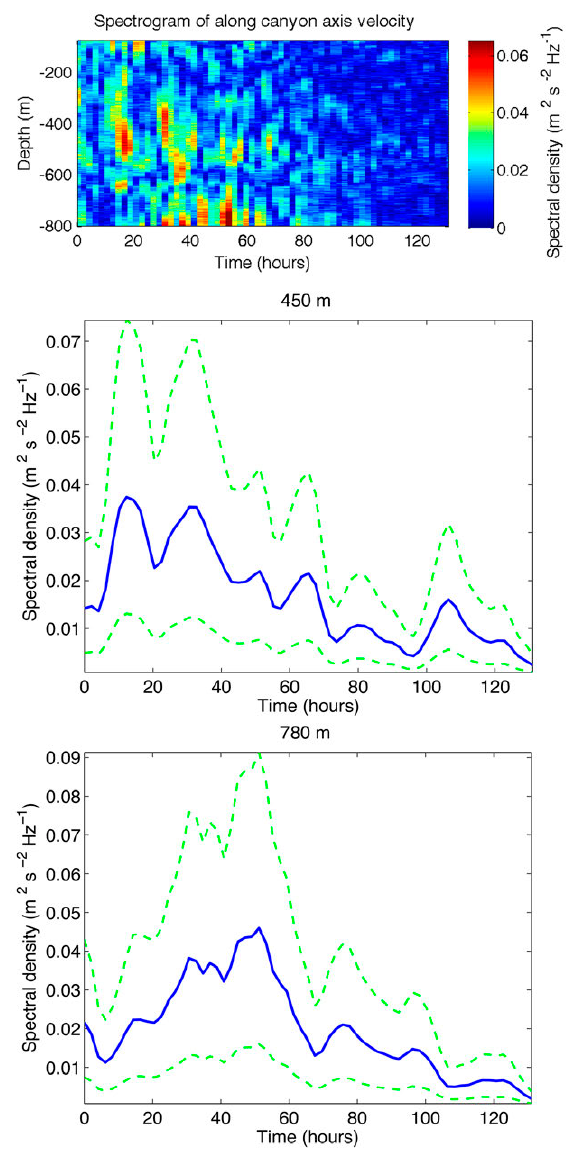
Fig. 5. – A, raw spectrogram of the along-canyon velocity compo- nent. Spectrograms at 450 m (B) and 780 m (C) smoothed with a Daniell’s window of six terms. Dashed lines represent 95% confi- dent levels.